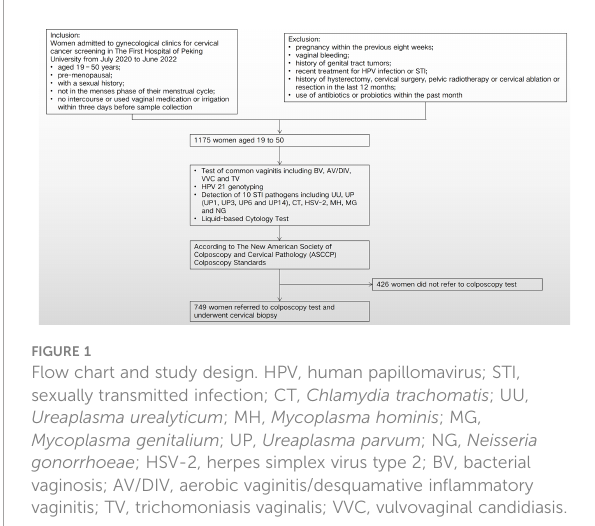
FIGURE 1 Flow chart and study design. HPV, human papillomavirus; STI, sexually transmitted infection; CT, Chlamydia trachomatis ; UU, Ureaplasma urealyticum ; MH, Mycoplasma hominis ;